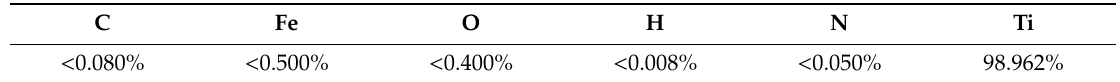
Table 1. Chemical composition of Ti G4.